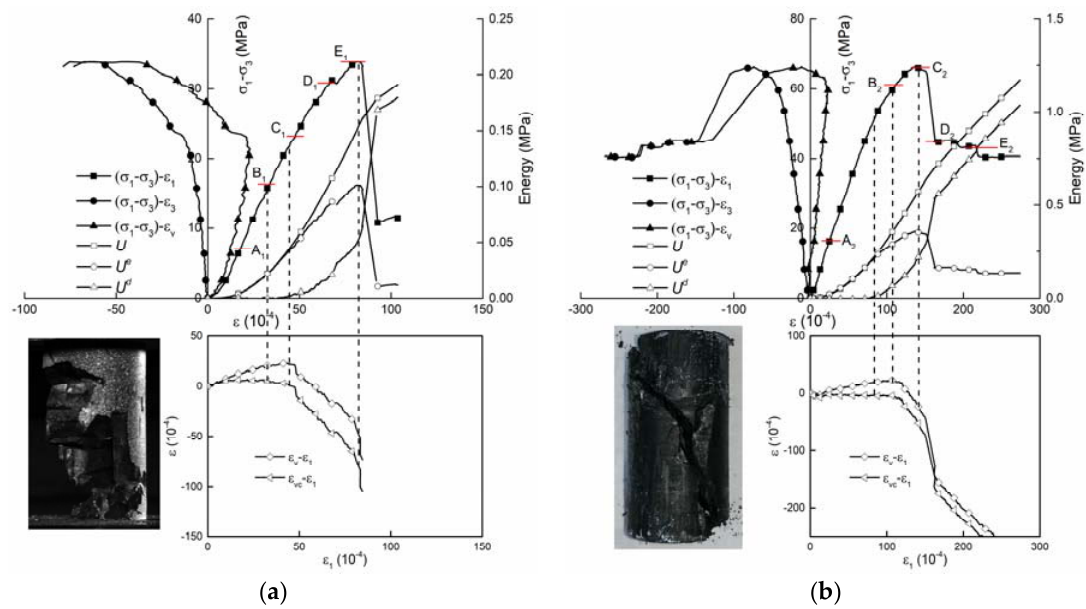
Figure 4. The typical stress–strain curves of coal in ( a ) uniaxial compression; ( b ) triaxial compression.